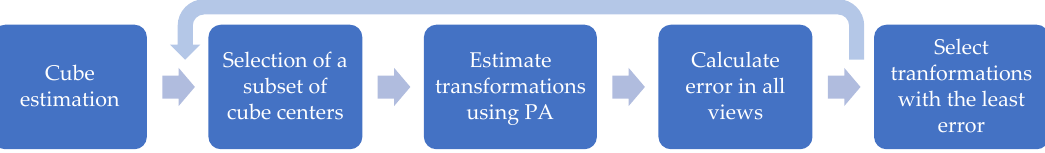
Figure 3. Pipeline of the calibration method based on 3D markers.